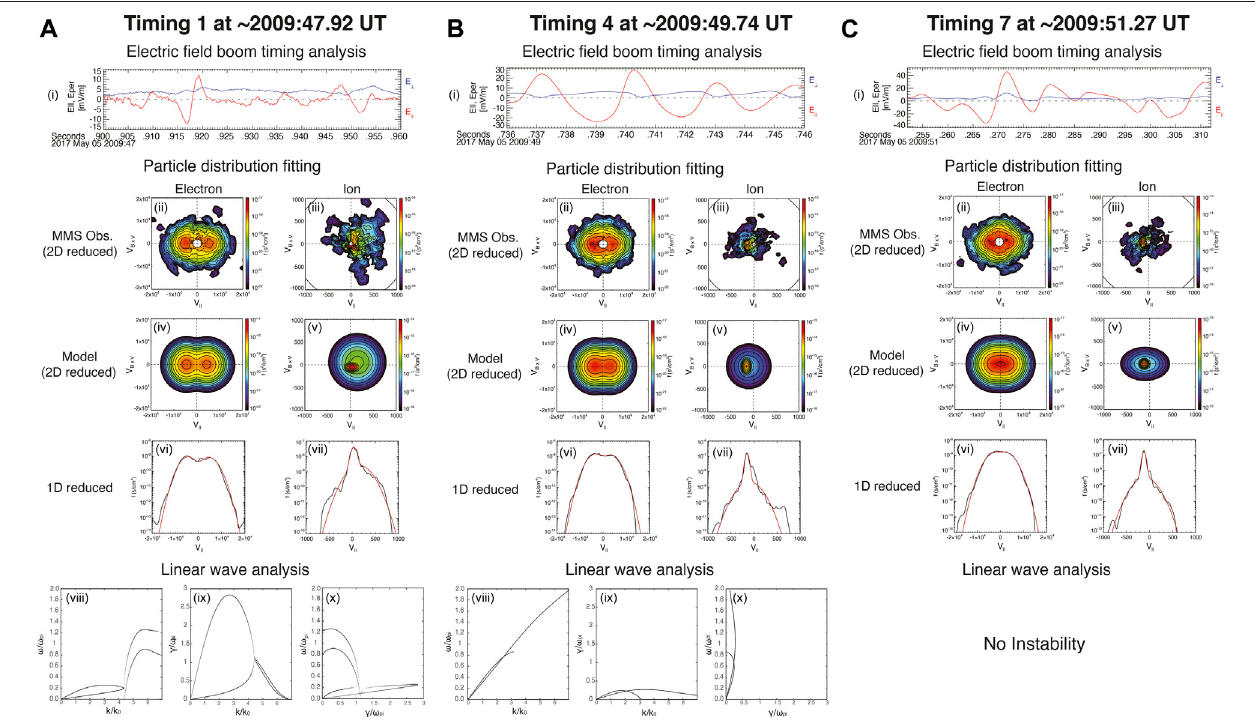
FIGURE 5 | Analysis of the waves observed at timing, 1 (A) , 4 (B) , and 7 (C) marked in Figure 4K : (i) the electric fi eld decomposed into the parallel (red) and perpendicular (blue) components to B ; (ii,iii) MMS observations of 2-D reduced electron (ii) and ion (iii) distributions in the V || and V ⊥ (cid:2) B × ( V i × B ) plane; (iv,v) 2-D reduced model distributions in the V || and V ⊥ (cid:2) B × ( V i × B ) plane, by fi tting the observed distribution to a sum of two Maxwellian distributions; (vi,vii) 1-D reduced distributions in the V || axis for comparisons between model (red) and observation (black). These modeled distributions are used to perform the linear kinetic instability analysis using BO code (Xie, 2019). The results are shown in (viii,ix) the real and imaginary parts of the growing mode in ω − k space, where the frequency ω and the growth rate c are normalized to the ion plasma frequency ω pi , and the wave number k is normalized to k 0 (cid:2) ω pi / ( 10 3 km/s ) . The ω − c plot (x) shows in which frequency range waves are